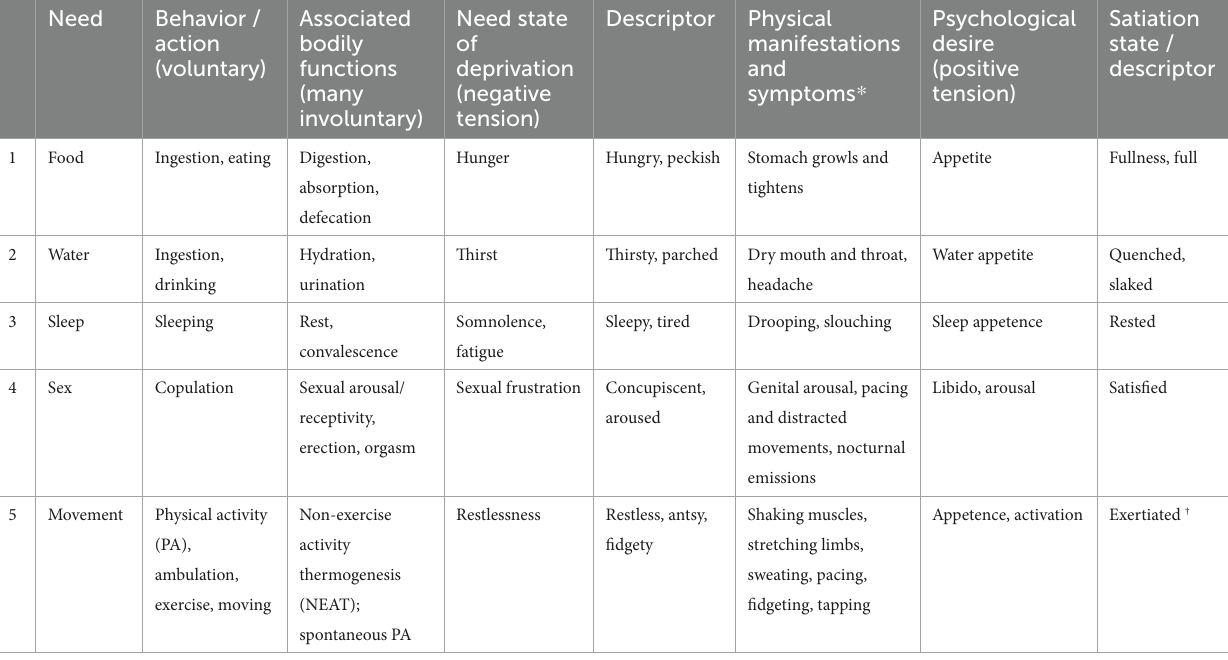
TABLE 1 Some classic, primary (i.e., “genuine”) drives, including bodily movement and physical activity.